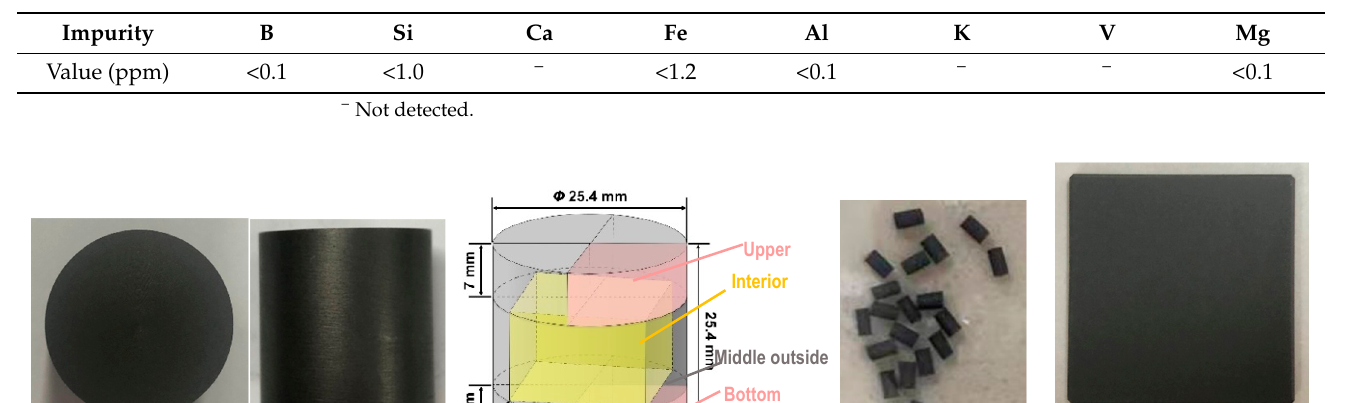
Table 1. The main impurities of graphite ET-10 [25].